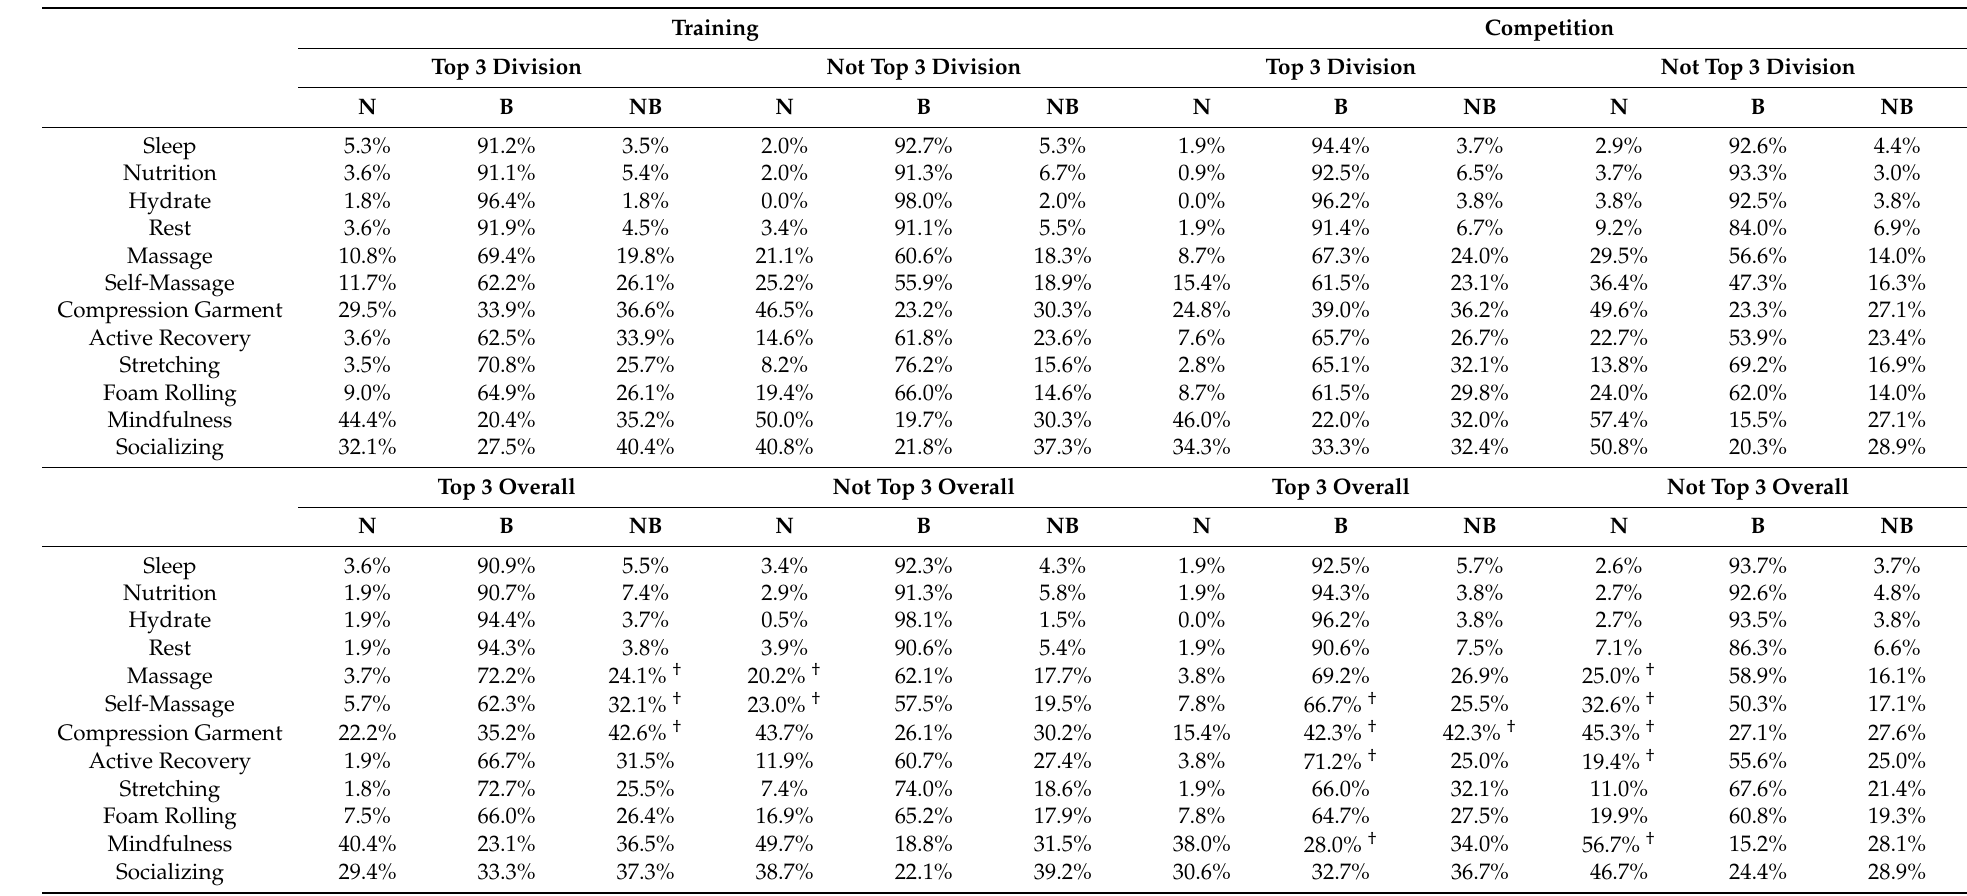
Table 4. Belief by competition